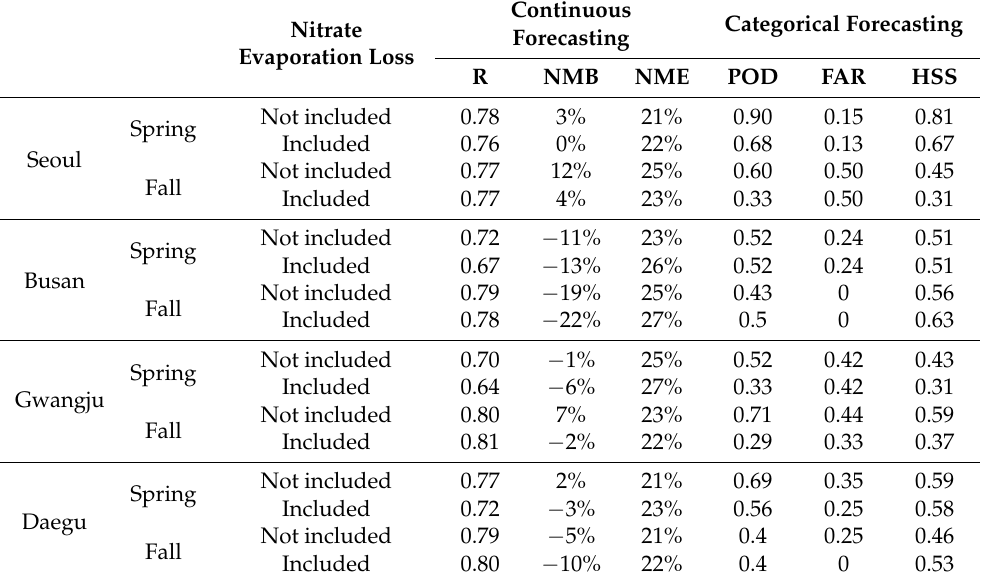
Table 7. Effect of inclusion of nitrate evaporation loss on the performance of continuous and categorical forecast at Seoul, Busan, Gwangju, Daegu during spring and fall in 2016. A threshold value for the categorical forecast was set to the daily mean PM 2.5 35 µ g/m 3 . Continuous Categorical Nitrate Forecasting Evaporation Loss